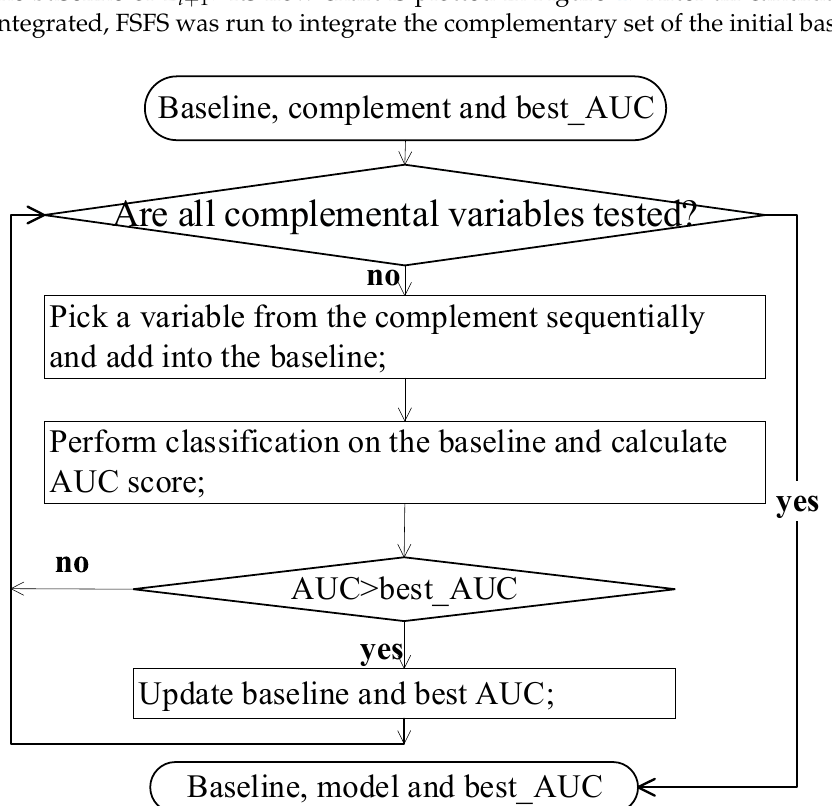
Figure 4. The flowchart of the feature selection step for the baseline and the complement in the multi-layer learning model.